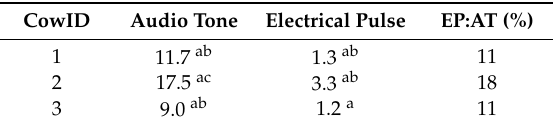
Table 6. Mean number audio tones and electrical pulses delivered, and mean ratio of EP:AT (%) for individual cows per day. Number of degrees of freedom (n.d.f.) and standard error of the di ff erence (SED) are presented. abc within a grazing allocation, for each type of stimuli, cow responses di ff er significantly from each